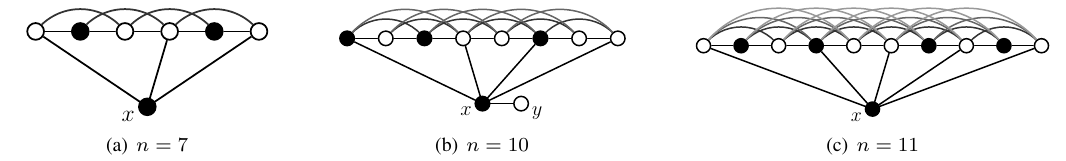
Fig. 2: Three graphs G such that γ ( G x ) − γ ( G ) is maximal. The black dots are an identifying code of G